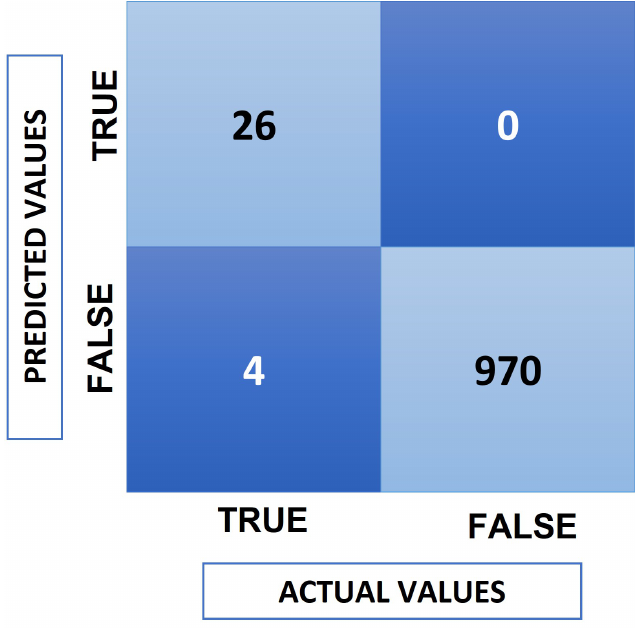
Figure 3. Confusion Matrix.